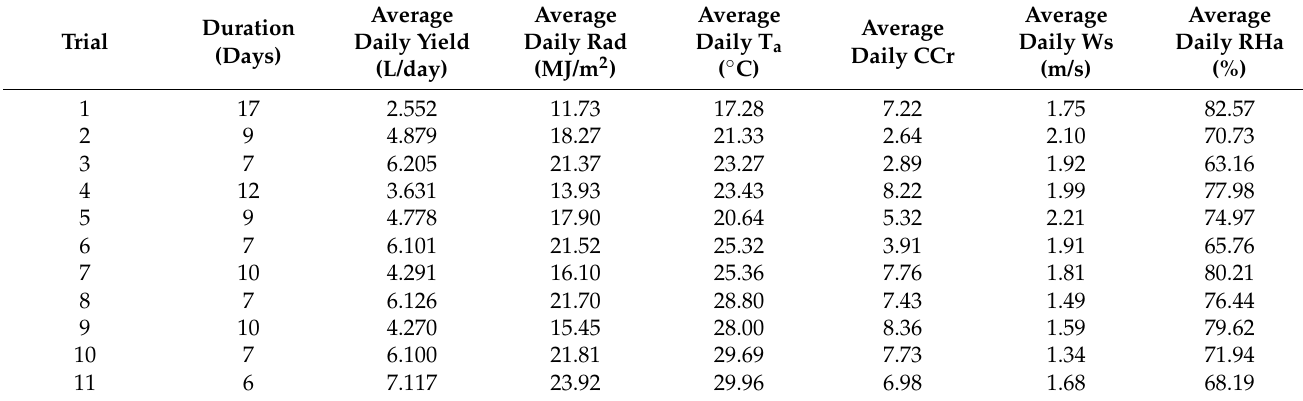
Table 3. Experimental data collected based on a 70% recovery